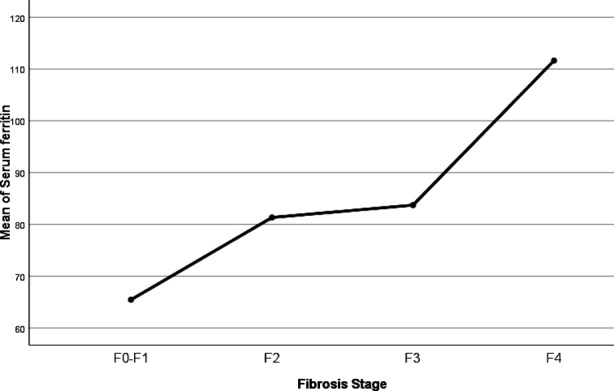
ANOVA Post-Hoc Means Plot of Serum Ferritin on Fibrosis Stage.